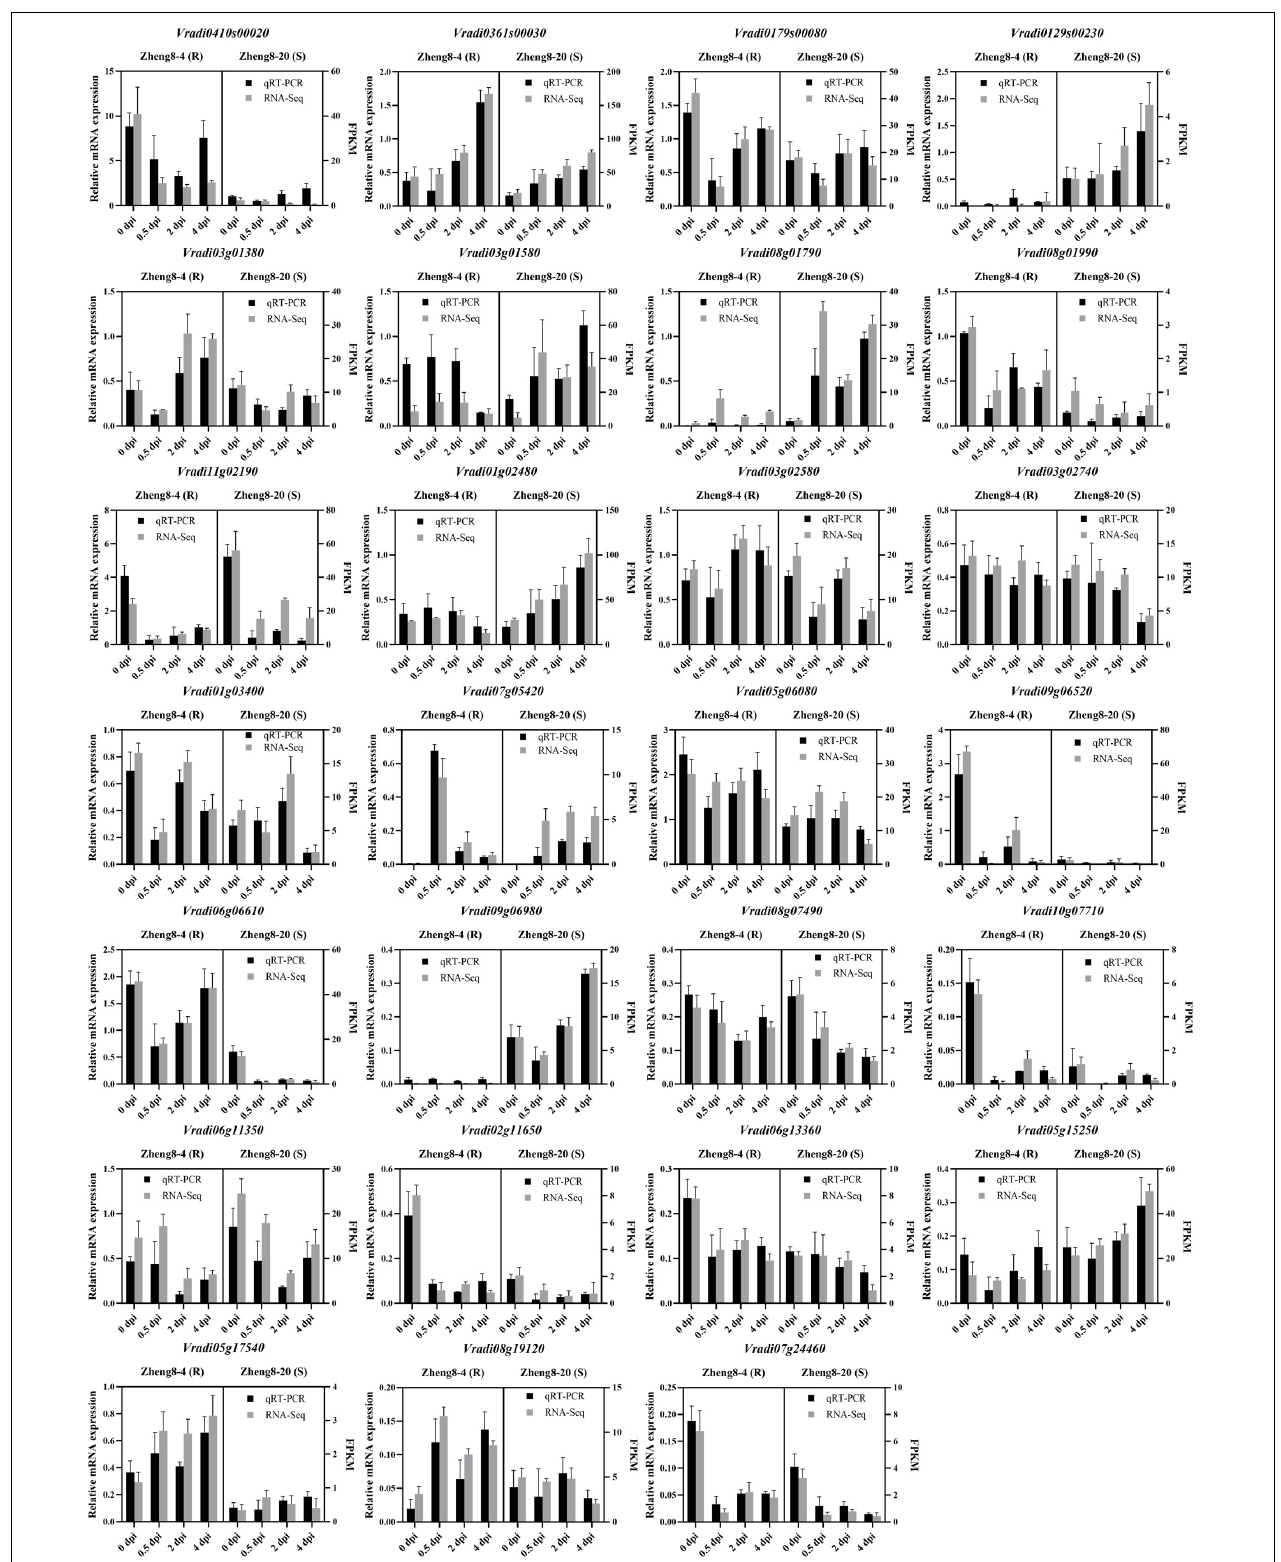
FIGURE 5 | qRT-PCR validation of the selected DEGs in mung bean. R, resistant line; S, susceptible line; dpi, day post inoculation.